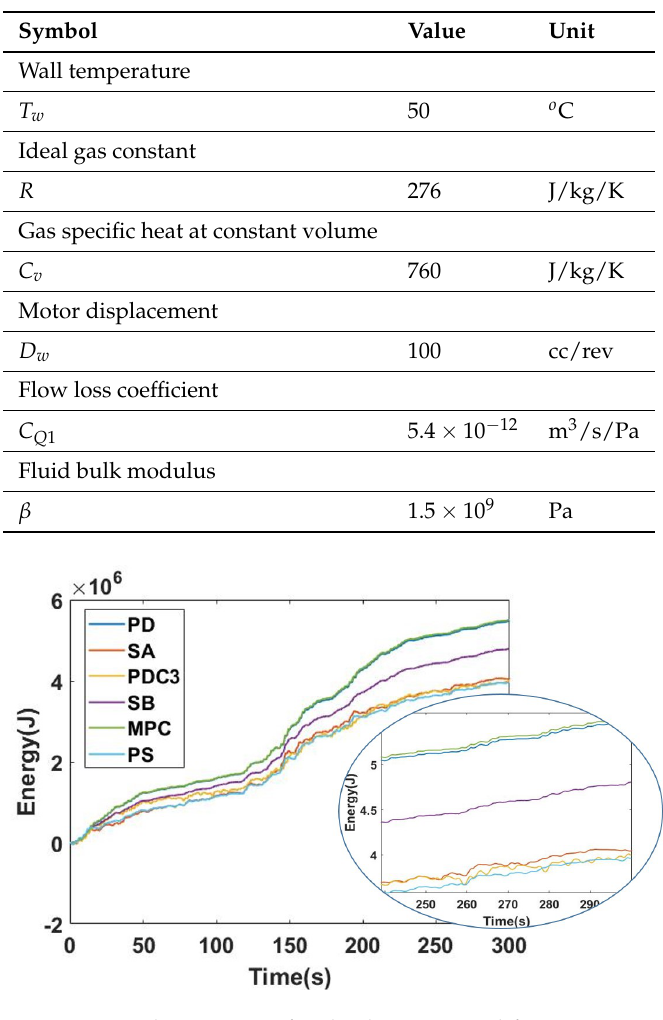
Figure 12. The energy extracted accounting for displacement and force constraints, including the hydraulic system dynamics model.